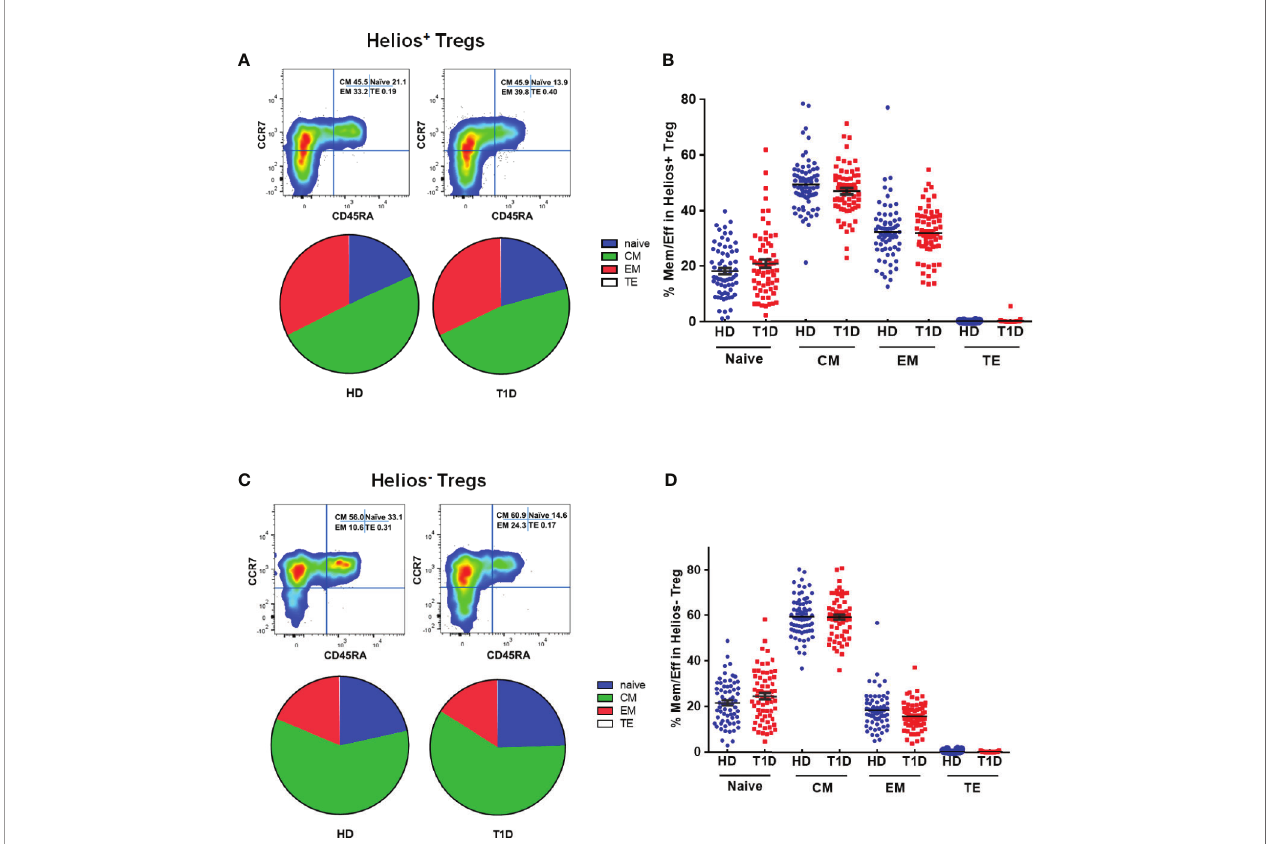
FIGURE 3 | Similar maturation status of both Helios + and Helios − Tregs in T1D individuals, compared with healthy donors (HD). The expression of CD45RA and CCR7 on CD4 + T cells from T1D and HD was analyzed by fl ow cytometry. (A, C) Pie charts summarize the data and each slice corresponds to the mean proportion of Helios + and Helios − Tregs for each phenotype. (B, D) Possible phenotypes are shown on the x-axis, whereas percentages of distinct T-cell subsets within Helios + and Helios − Tregs are shown on the y-axis. Each point represents a single individual. The results were from 68 autoantibody-positive T1D individuals and 68 age- matched autoantibody-negative healthy controls. Samples from T1D individuals and healthy controls were randomly divided to each independent experiment. One biological sample (from the same healthy donor and drawn at the same time) was performed as control for the experimental reproducibility. Comparisons between phenotype distributions were performed using the partial permutation test, and unpaired t test with Welch ’ s correction for each phenotype. A p value below 0.05 indicates a signi fi cant difference between